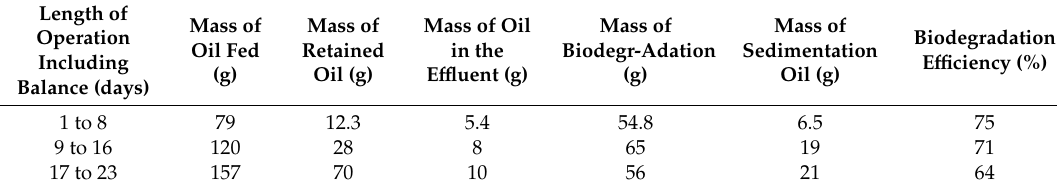
Table 3. Mass balance of fats and oils in the bench-scale activated sludge reactor.